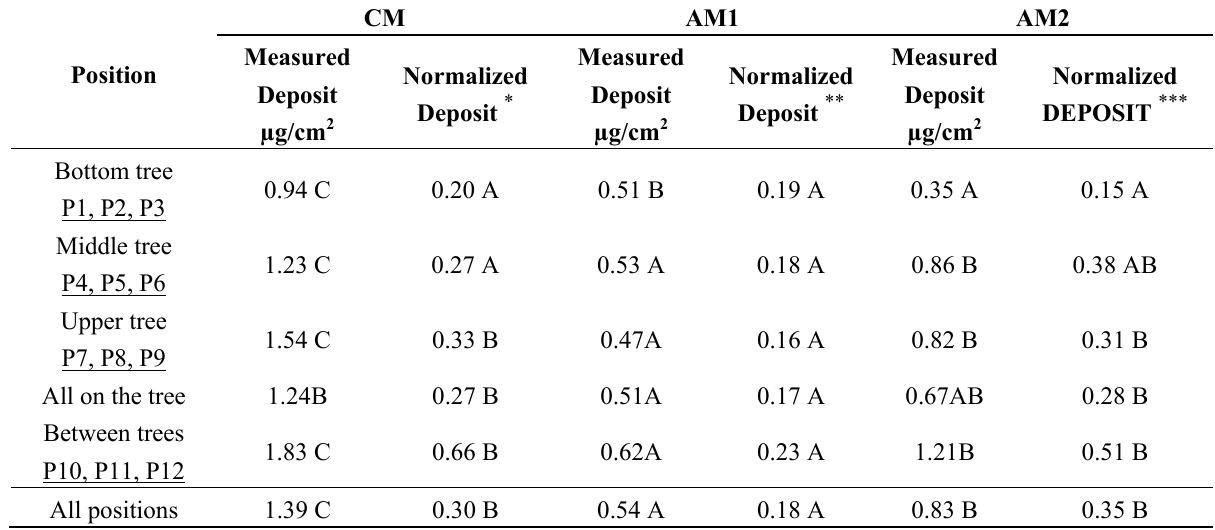
Table 4. Comparison between the tartrazine tracer deposit (µg/cm 2 ) in control and automated (AM) spray